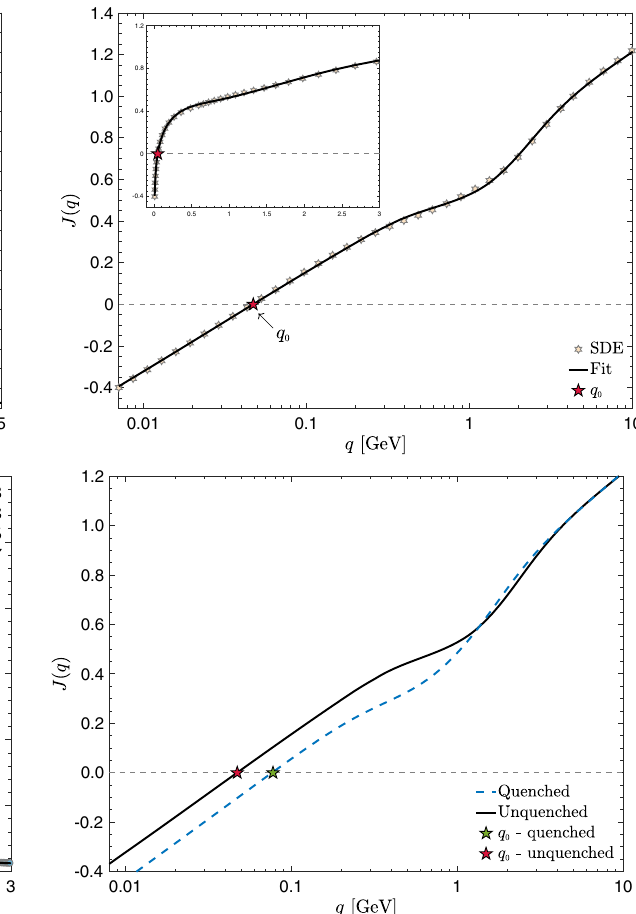
(black continuous), with the lattice data (solid circles in different col- ors for each β ). Bottom right panel: The quenched (blue dashed) and unquenched (black continuous) J ( q ) ; the stars indicate the momentum ) = q J ( q 0 where 0